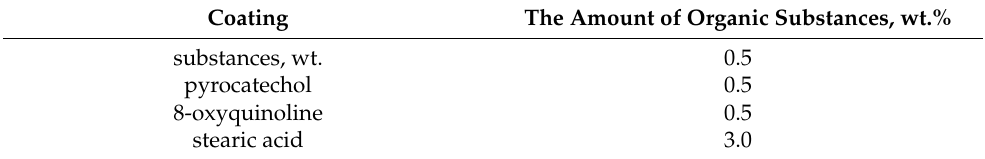
Table 2. Content of modifiers .